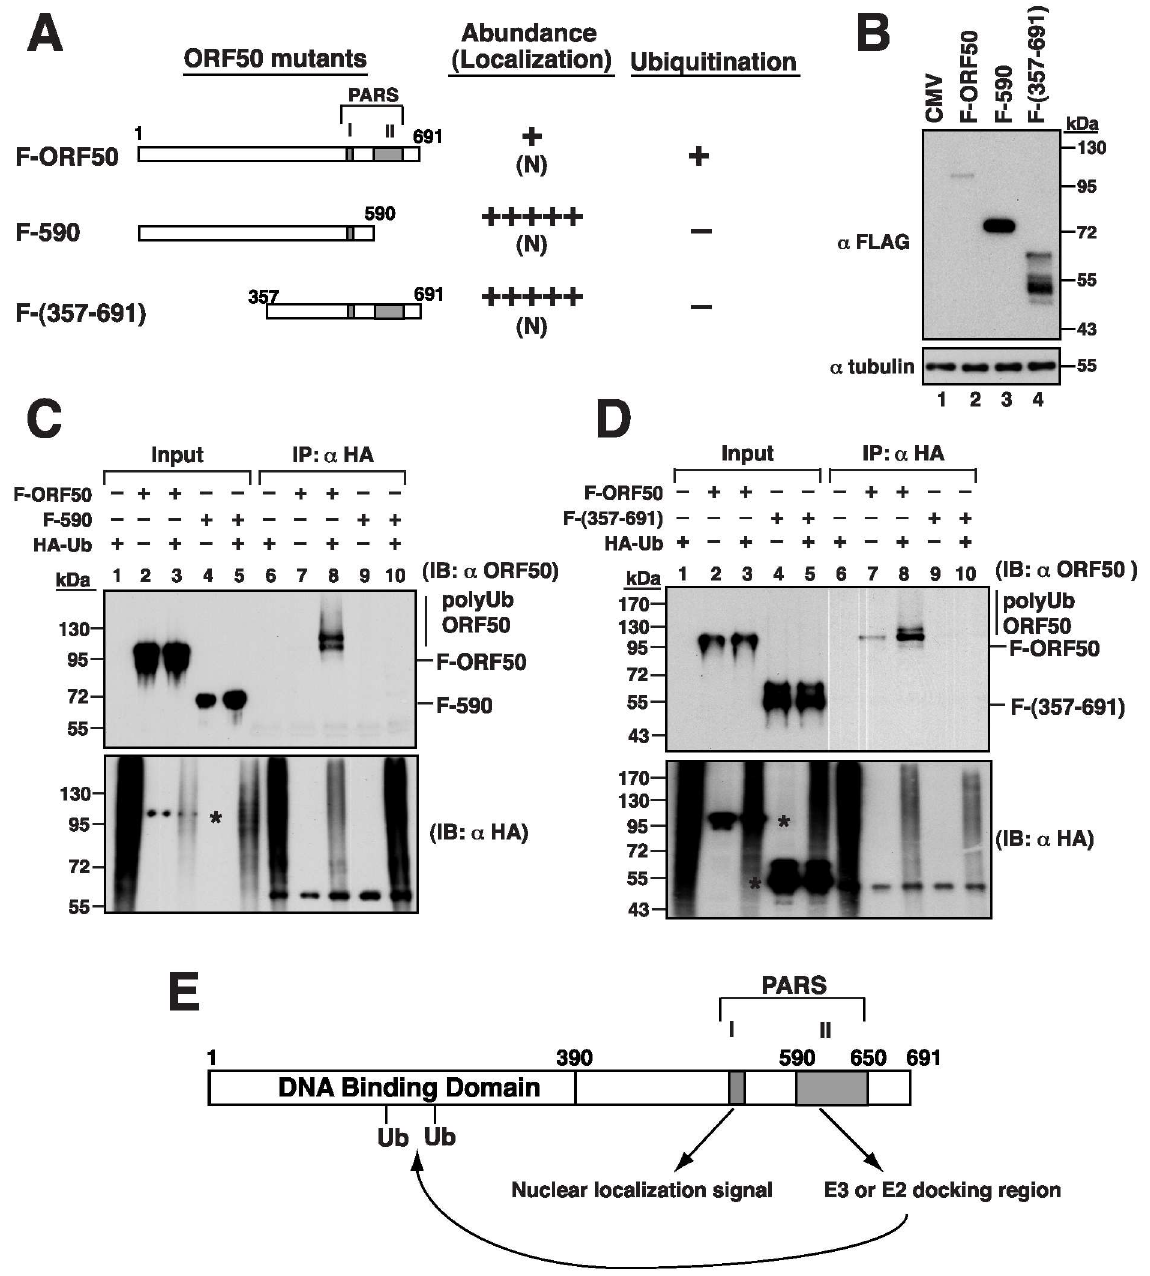
Fig 7. Both N-terminal and C-terminal regions in ORF50 are required for ubiquitination. (A) Deletionconstructs of ORF50 and a summary of their intracellular localization,protein abundanceand ubiquitination status. (B) Immunoblot analysis of F-ORF50, F-ORF50(1–590)and F-ORF50(357–691) in 293T cells. (C and D) Mutants F-ORF50(1–590)and F-ORF50(357–691) were evaluatedfor ubiquitination in 293T cells. Cells were transfected with the indicatedplasmids. At 16 hr after transfection, cells were treated with MG132 for another 24 hr. Cell lysates were immunoprecipitated and immunoblotted as describedin Fig 6B. Asterisks indicate the cross-reaction of ORF50 with the used antibodies(S4 Fig). (E) Proposedmodel for ORF50 ubiquitination. The PARS-I is responsible for the nuclear translocation of ORF50, and the PARS-II motif is requiredfor the bindingof specific ubiquitinenzymes. The ubiquitinacceptor sites are likely to be located in the N-terminal 356-aa